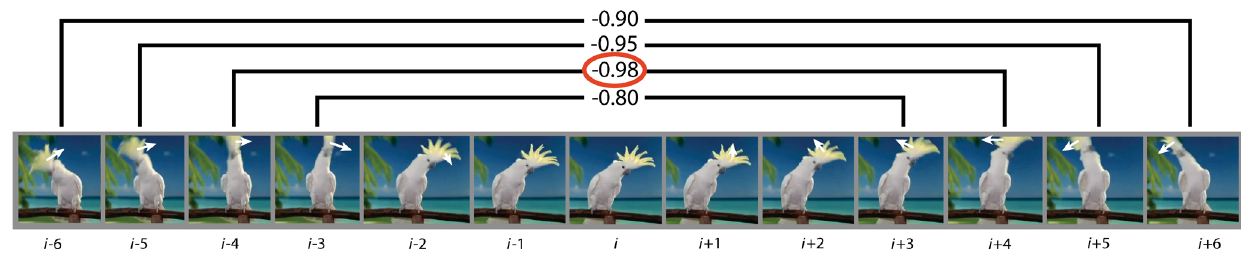
Fig. 3 Temporal window in which pairs of frames are compared. White arrows mark the approximate direction in which the parrot’s head is moving. The dot product is computed for each pair of frames and the minimum is chosen as the direction-change score for that frame; the dot product is actually computed separately for each window in the 8 × 8 grid.